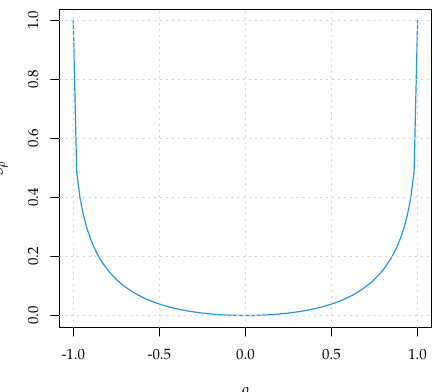
Figure 1. Relation between S ρ and the correlation coefficient ρ under the bivariate Gaussian